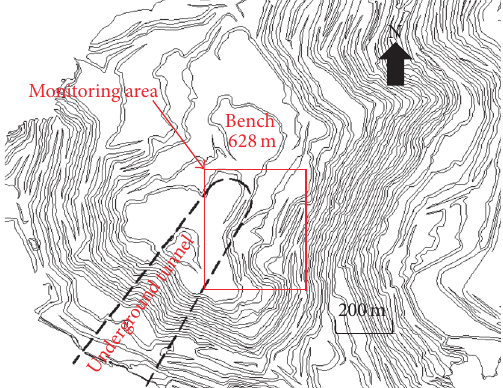
Figure 2: Transport tunnel position of the open-pit mine.